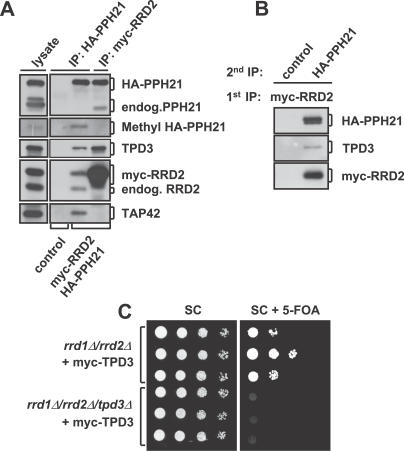
RRD2 Interacts Physically and Functionally with TPD3(A) HA-PPH21 or myc-RRD2 immunoprecipitates (IP) from lysates of wild-type (wt) cells co-expressing HA-PPH21 and myc-RRD2 were analyzed by SDS-PAGE and immunoblotting. The blots were sequentially incubated with anti-methyl PP2A/PPH21 (2A10), rabbit polyclonal anti-TPD3, anti-RRD2, anti-TAP42, and anti-PPH21 antibody. endog., endogenous.(B) Anti–Myc-tag immunoprecipitates from lysates of wild-type cells co-expressing myc-RRD2 and HA-PPH21 were eluted by peptide competition and re-immunoprecipitated via HA-PPH21 (see Materials and Methods for details). “Control” indicates a wild-type strain containing both empty vectors. The re-immunoprecipitates were analyzed by SDS-PAGE and immunoblotting using specific antibodies.(C) rrd1Δ/rrd2Δ and rrd1Δ/rrd2Δ/tpd3Δ cells containing the plasmid PYES2[myc-TPD3] were grown to log phase in complete dropout medium. Growth of the double and triple mutant was compared by spotting equal amounts of 10-fold serially diluted cells onto synthetic complete (SC) medium plates ± 1 g/l 5-fluoroorotic acid (5-FOA). The plates were incubated for 2 d (SC) or 5 d (SC + 5-FOA) at 30 °C. Screening on 5-FOA selects for the loss of the URA3 plasmid PYES2[myc-TPD3] and indicates dependency of viability on TPD3.